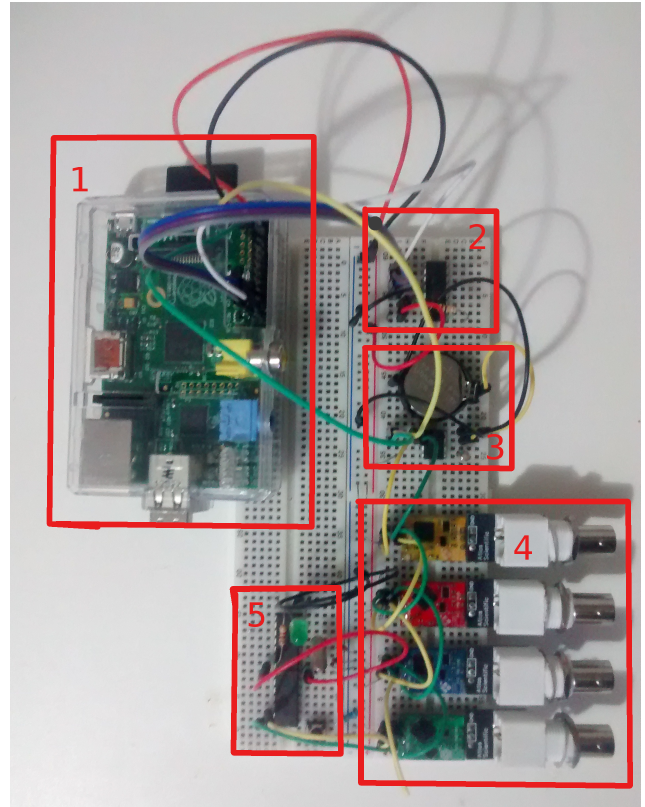
Figure 6. Prototype board of the electronic circuit implemented for the monitoring cycle, the roles/components of each functional part are: (1) Central Computer (RPi); (2) Sensor Module (MCP3008 circuit); (3) Central Computer (RTC circuit); (4) Sensor Module (EZO boards); (5) Actuator Module (AtMega